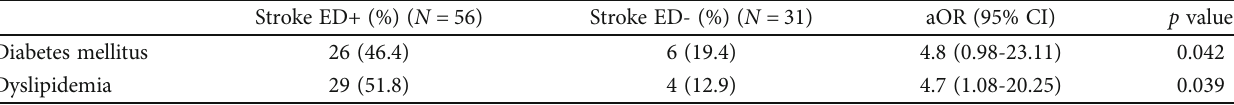
Table 5: Predictive factors of poststroke